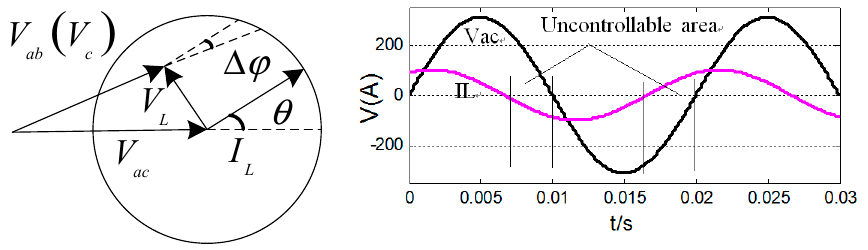
Figure 3. The diagram of vector and uncontrollable area.